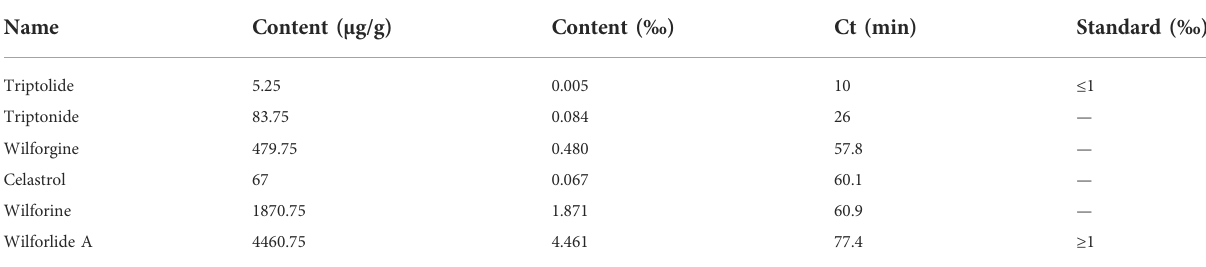
TABLE 4 Content assay of six components in